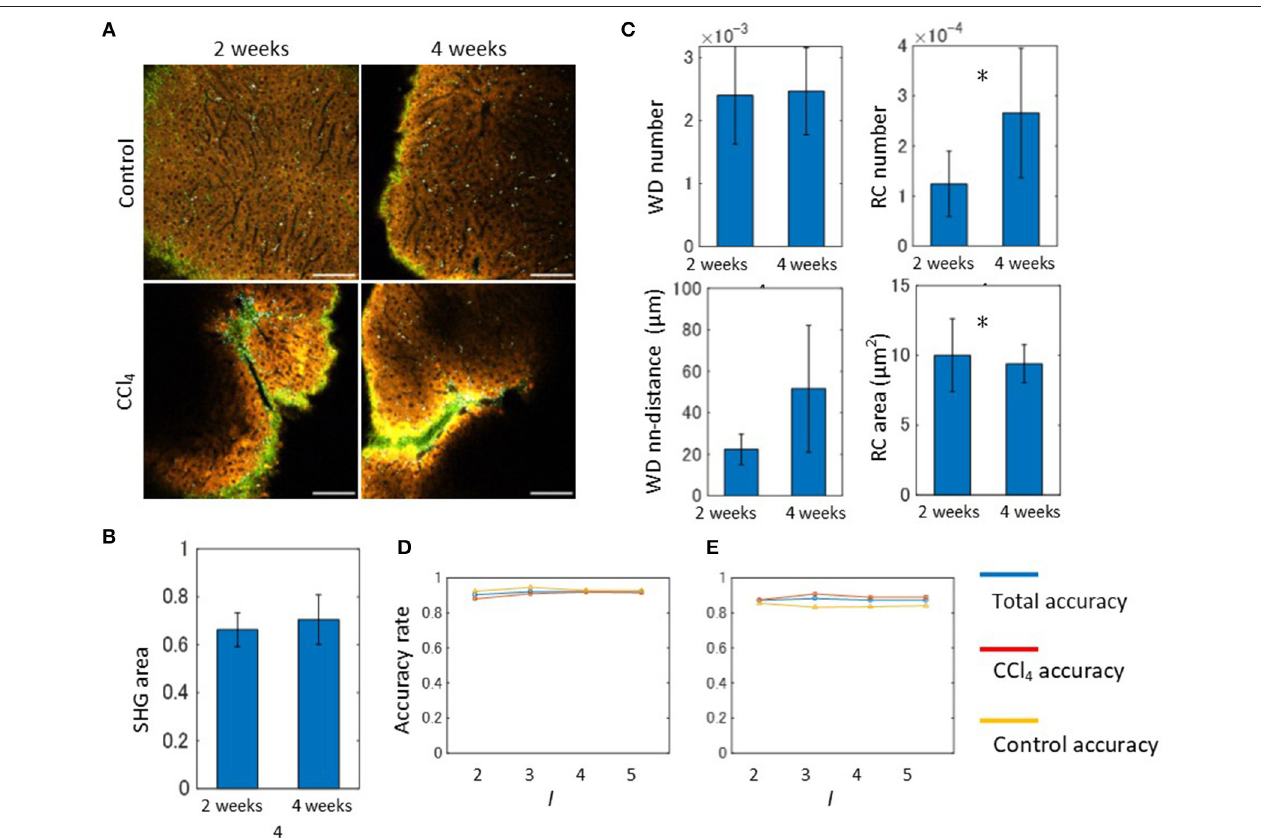
FIGURE 6 | Spectral image morphometry: 2-weeks model vs. 4-weeks model. (A) MP excitation spectral imaging for liver tissues of the 2- and 4-weeks CCl 4 models. Scale bar, 100 µ m. (B) Quantification result of the ratios of SHG signal area to the total image area. (C) Mathematical morphology analyses performed on the 2- and 4-weeks CCl 4 model. The graphs shown are the ratios of the number of WD sites and RC sites to the total signal area, and the averaged nearest neighbor distance between WD sites, and the averaged areas of RC to the total signal area. Asterisks indicate statistical significance with the Kolmogorov-Smirnov test with p < 0.05. (D) Results of the automated classification test performed on the 2- and 4-weeks CCl 4 models. The total, CCl 4 , and control accuracy rates are depicted as blue, red, and yellow lines, respectively. (E) Results of the classification test performed on the 2- and-4 weeks CCl 4 models excluding SHG marker information. The total, CCl 4 , and control accuracy rates are depicted as blue, red, and yellow lines, respectively.